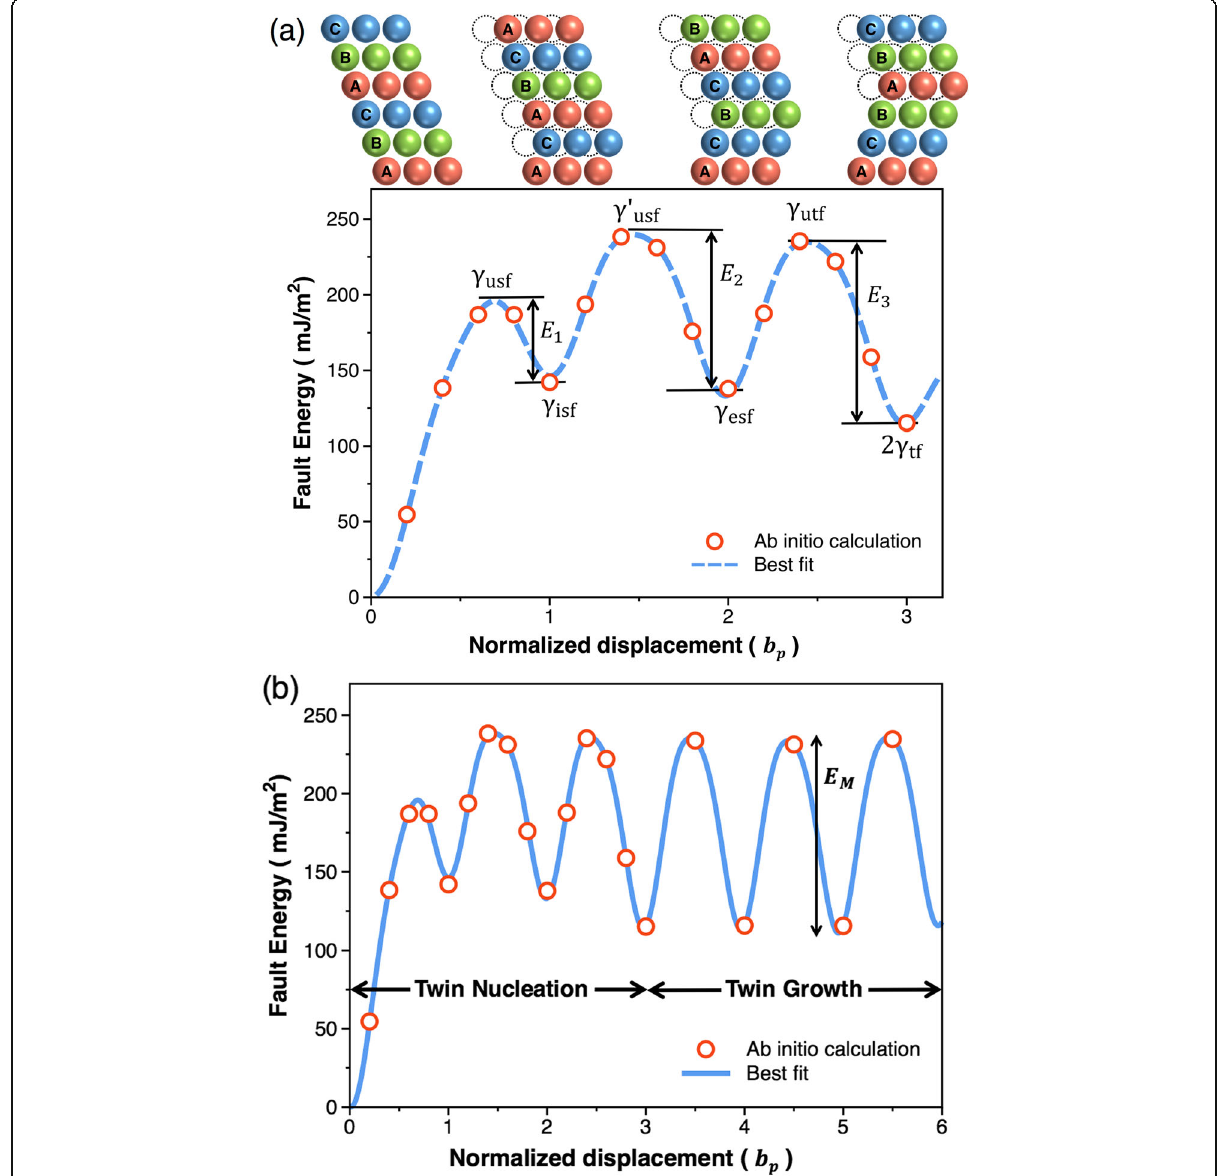
Fig. 2 a The GPFE curve of a perfect Al crystal calculated using DFT showing the changes in the fault energy associated with the nucleation an embryonic twin consisting of three fault layers. b The GPFE curve depicting the growth of the nucleated twin by the consecutive activation of the partial dislocation in the neighboring (111) plane. Here, b P (= a 0 =